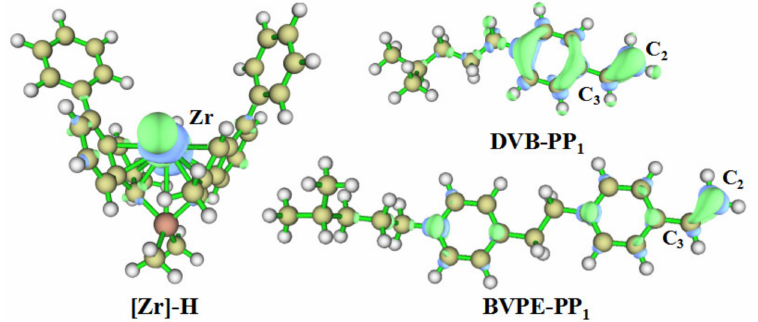
Figure 8. Isosurface maps of Fukui functions for Zr ( f + ) in[Zr]-H and C 2 , C 3 ( f − ) in DVB-PP 1 and [BVPE]-PP 1